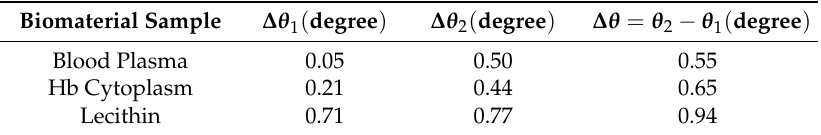
Table 4. Angular shit of SPR angle for different biomaterial sample detection. Biomaterial